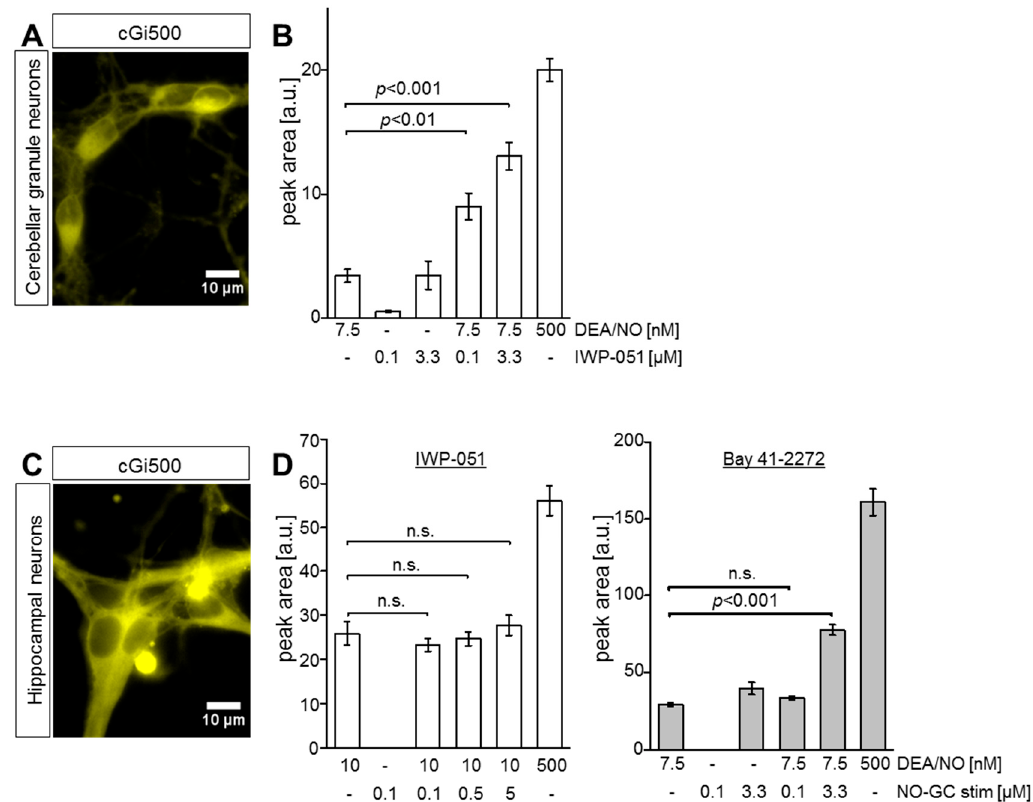
Figure 4. IWP-051 potentiates DEA/NO-induced cGMP signals in primary cerebellar granule neurons (CGNs), but not in hippocampal neurons (HNs). ( A ) Representative picture of primary cGi500-expressing CGNs (yellow) isolated from R26-CAG-cGi500(L1) mice; ( B ) Statistical analysis of cGMP imaging in CGNs, showing peak areas of cGMP signals evoked by DEA/NO and IWP-051. Respective concentrations are indicated below the graph; data are shown as mean ± SEM ( n = 7 cells from two coverslips); ( C ) Representative picture of primary cGi500-expressing HNs (yellow) isolated from R26-CAG-cGi500(L1) mice; ( D ) Statistical analysis of cGMP imaging in HNs, showing peak areas of cGMP signals induced by DEA/NO and IWP-051 (left, n = 12 cells from two coverslips) or DEA/NO and Bay 41-2272 (right, n = 6 cells from one coverslip). Data are shown as mean ± SEM. Respective concentrations are indicated below the graphs; n.s. not significant.